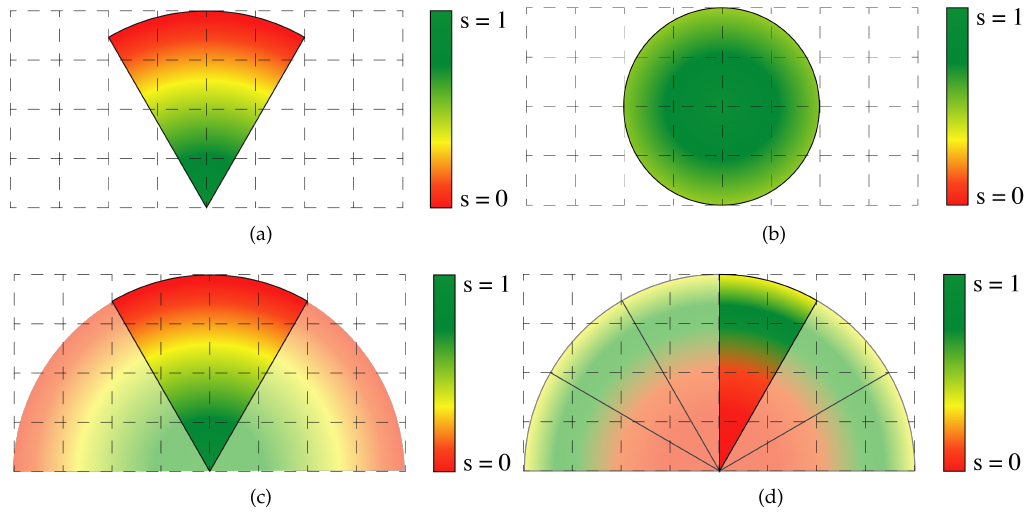
Figure 1. ( a ) A fixed camera observes the environment without varying the spatial confidence for each cell at each time step. ( b ) Example of the distributiBon of the spatial confidence in the area surveyed by an unmanned aerial vehicle (UAV). ( c ) At each time step, pan-tilt-zoom (PTZ) camera can pan between different positions. ( d ) PTZ cameras can also zoom in to an area, which causes their FoV to shrink, but improves the spatial confidence in areas further away from the